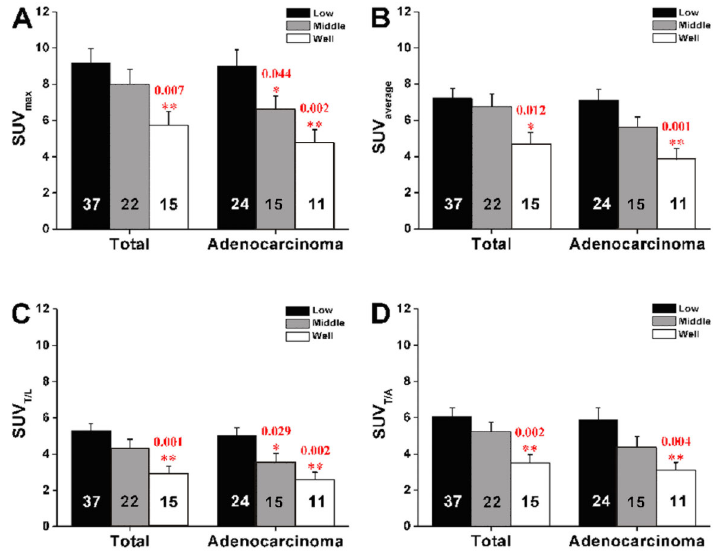
Figure 3. Tumor differentiation-based group dif- ference for standardized uptake values (SUVs). One-way ANOVA followed by the LSD post hoc test was used for statistical analyses. See Figure 1 for explanation of